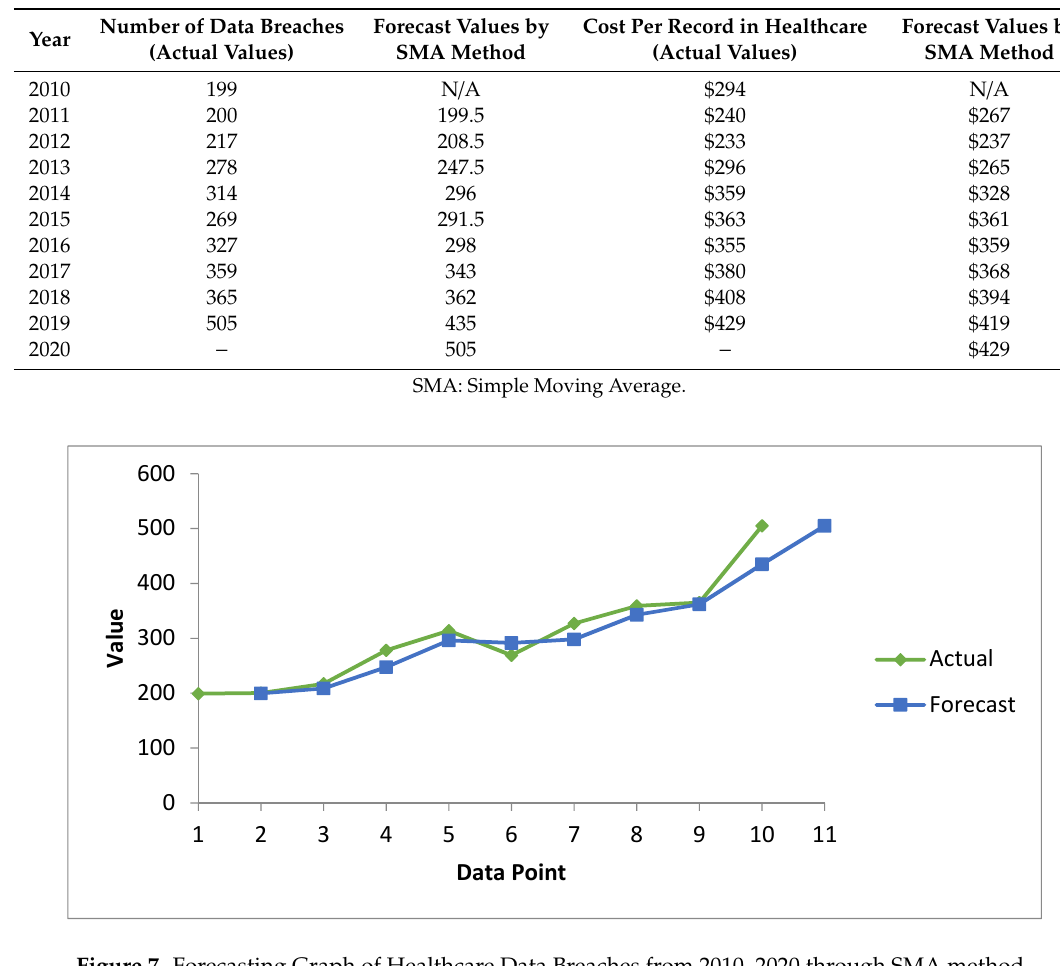
Figure 7. Forecasting Graph of Healthcare Data Breaches from 2010–2020 through SMA method.